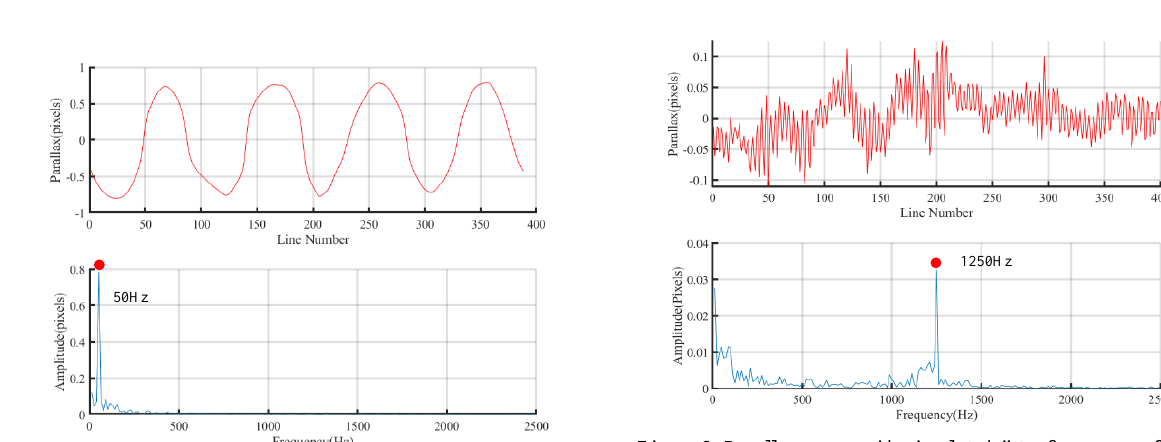
Figure 8. Parallax curve with simulated jitter frequency of 1250 Hz, matching window size is 128(cross)* 32(along)